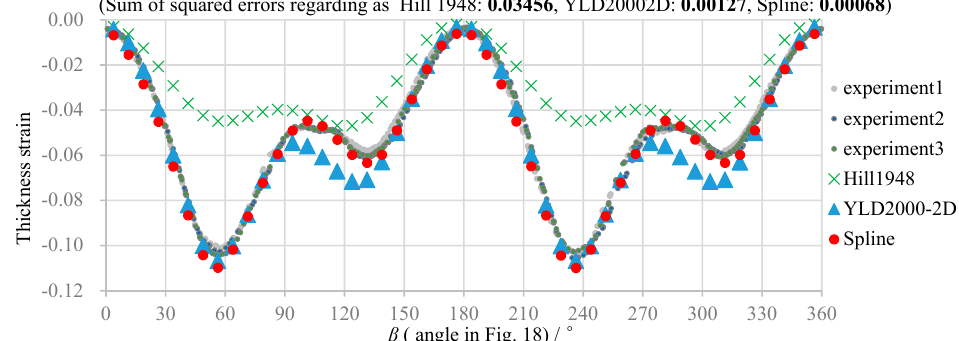
Figure 25. Comparison of thickness strain distributions on circle 1 in experiment condition D.